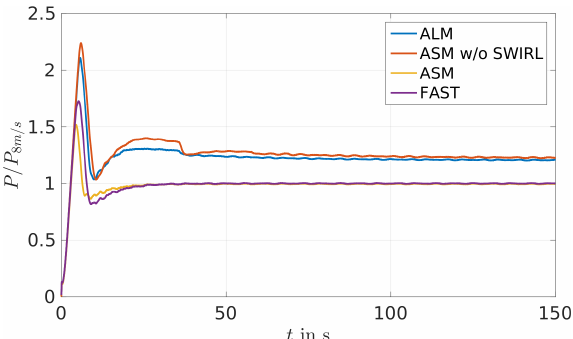
Figure 4. Comparison of different simulation methods for the gen- erator power of the eno114 3.5MW turbine in a laminar case with a wind speed of 8ms − 1 , normalised by the respective value of the eno114 3.5MW energy power curve at 8ms − 1 .